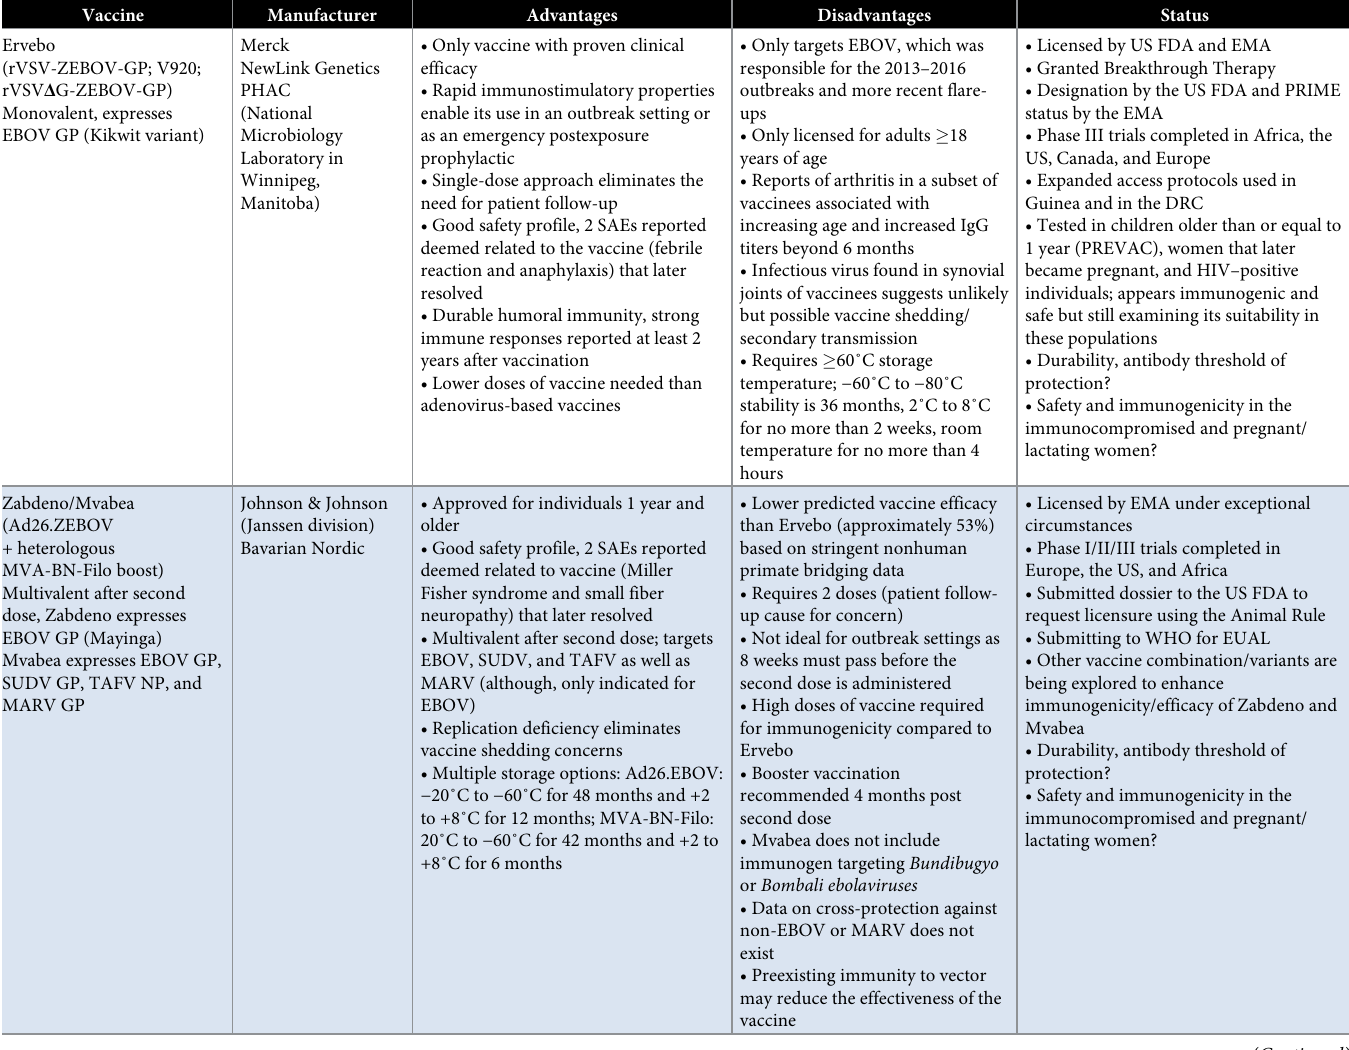
Table 1. Advantages and disadvantages of post-Phase I clinical trial vaccines for EBOV disease.